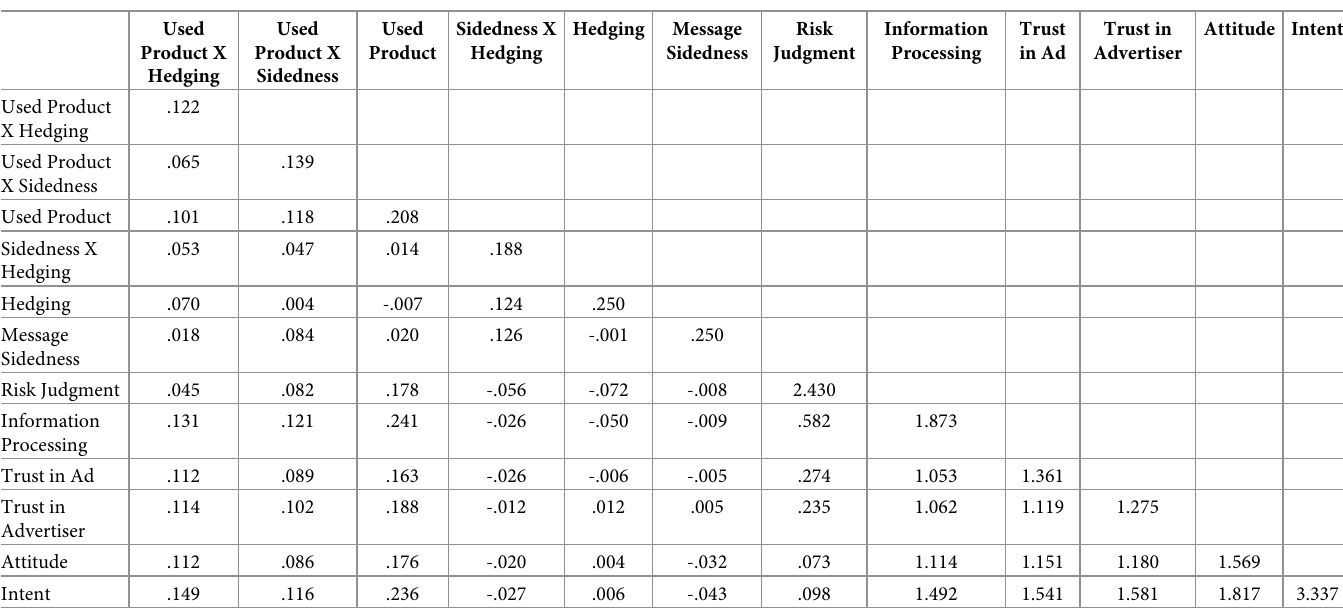
Table 3. Covariance matrix.